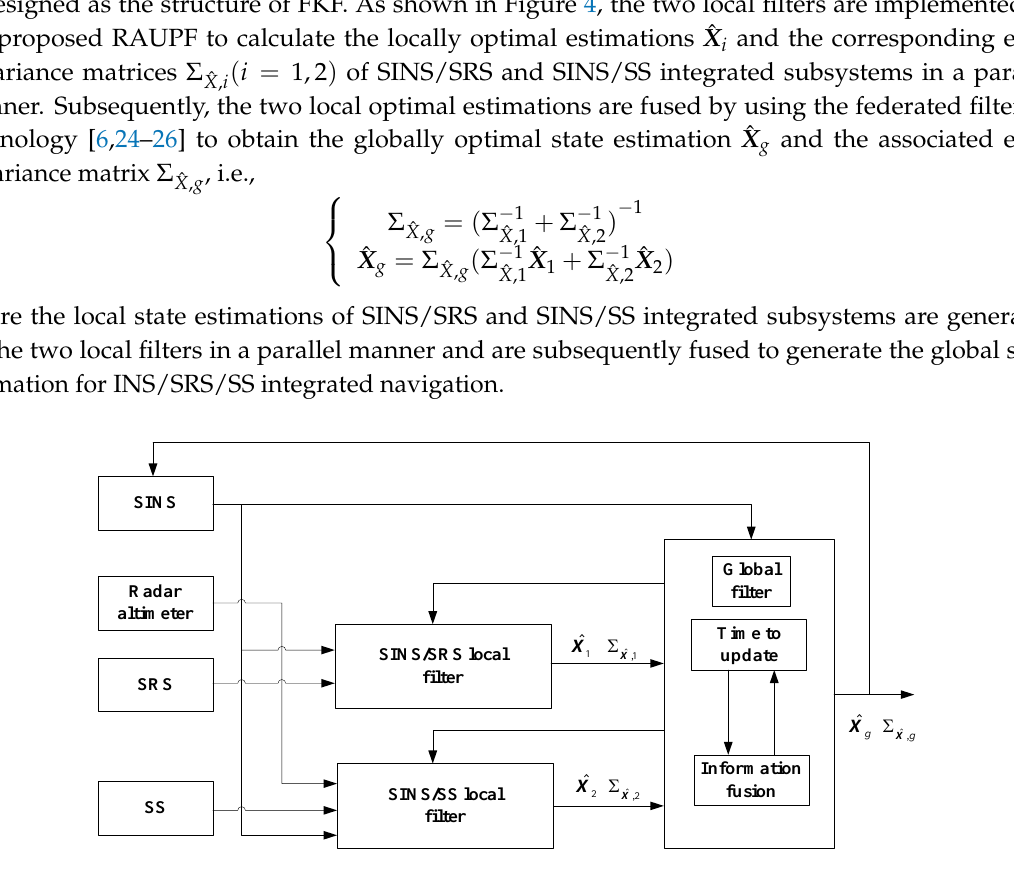
Figure 4. The fusion principle of SINS/SRS/SS integrated navigation system.